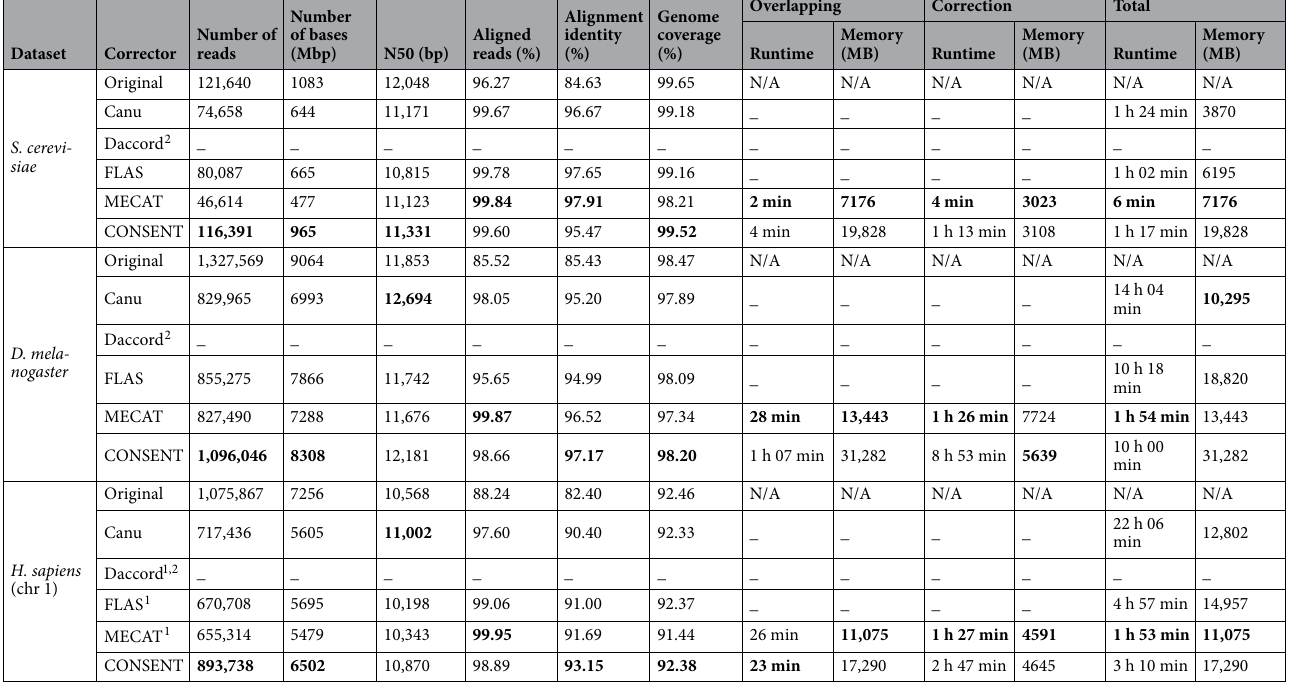
Table 2. Statistics of the real long reads, before and after correction with the different methods. Best results for each metric is highlighted in bold. 1 Reads longer than 50 kbp were filtered out, as ultra-long reads caused the programs to stop with an error. There were 1824 such reads in the original dataset, accounting for a total number of 135,364,312 bp. 2 Daccord could not be run on these two datasets, due to errors reported by